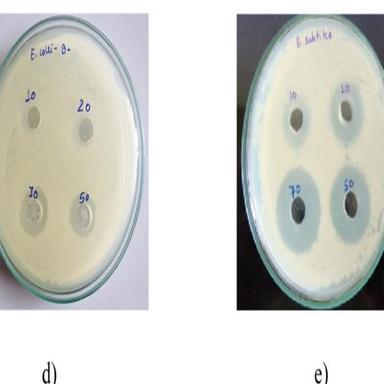
Zone of inhibition against – a) Staphyloccous. aureus, b) Bacillus. subtilis, c) Escherichia. coli, d) Enterobacter. aerogenus, e) Salmonella typhia.